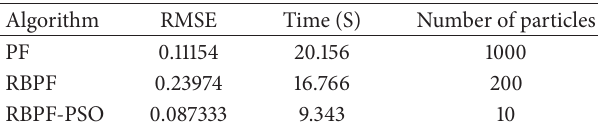
Table 2: Performance comparison between PF, RBPF, and RBPF- PSO.